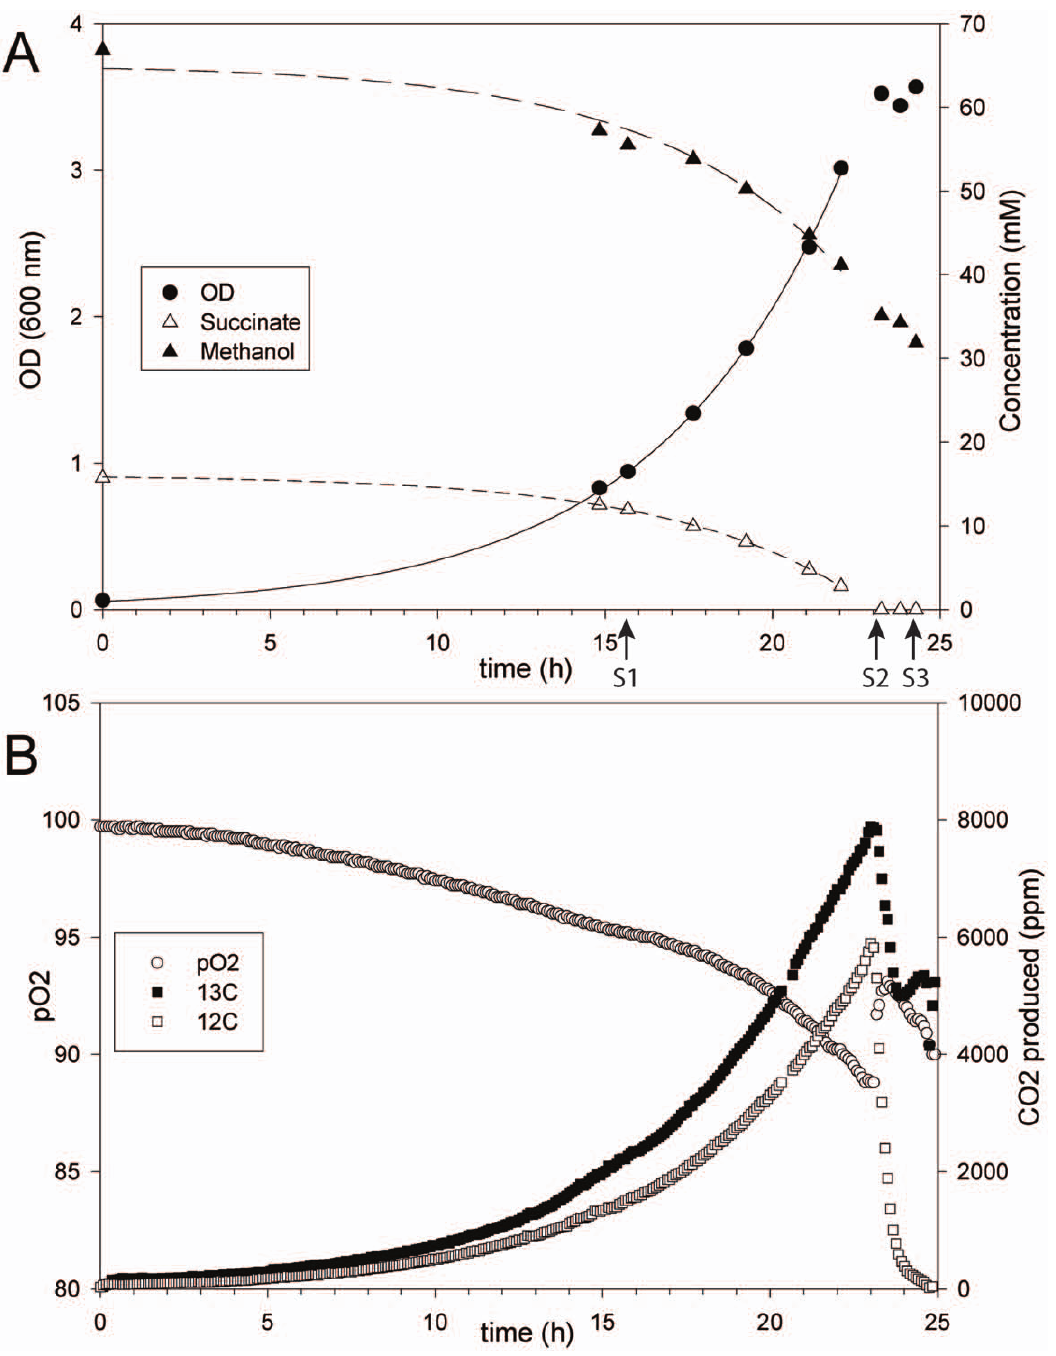
Figure 1. Monitoring of M.extorquens AM1 growth parameters in batch-culture with 60 mM methanol plus 15 mM succinate. A. Monitoring of Optical Density (OD) at 600 nm (black circle), methanol consumption (black triangle) and succinate (white triangle) consumption. B. Monitoring of oxygen partial pressure (pO 2 ) (white circle), 13 C (black square) and 12 C (white square) CO 2 production in exhaust gas. Metabolite sampling was performed at three timepoints as indicated in A: mid-co-consumption phase (Sampling time 1, S1), end co-consumption phase (Sampling time 2, S2), and transition phase (Sampling time 3, S3). The figure shows data of one replicate. doi:10.1371/journal.pone.0048271.g001 of the label into the gluconeogenesis pathway. Indeed, mono- isotopomer fractions indicated that 20% of monolabeled 2- phosphoglycerate is generated from the serine cycle, i.e., glycine labeled phosphoglycerate was generated, which can lead to the incorporation of the label into phosphoenolpyruvate, the precursor plus Me-THF condensation (Figure 4). This observation indicates of phenylalanine and tyrosine, and/or via gluconeogenesis into that serine is produced at least partially ( . 20%) from the hexose-phosphate. An analysis of the hexose-phosphate mass